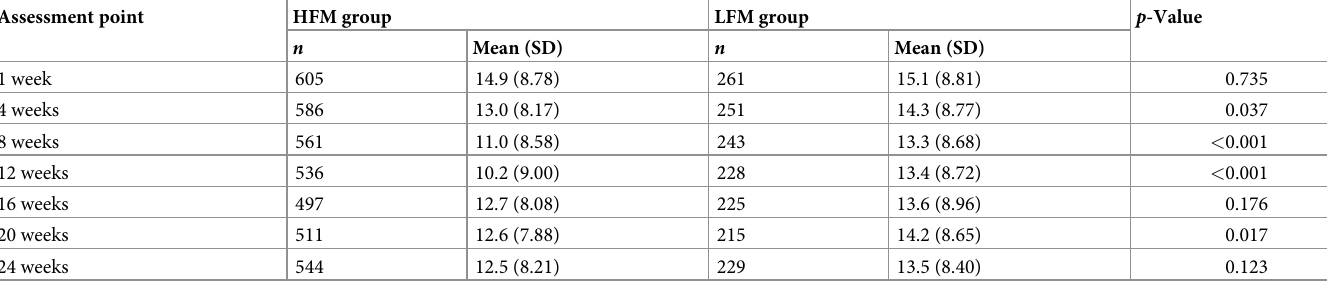
Table 3. Cigarettes consumed � per day during intervention and follow-up period by intervention